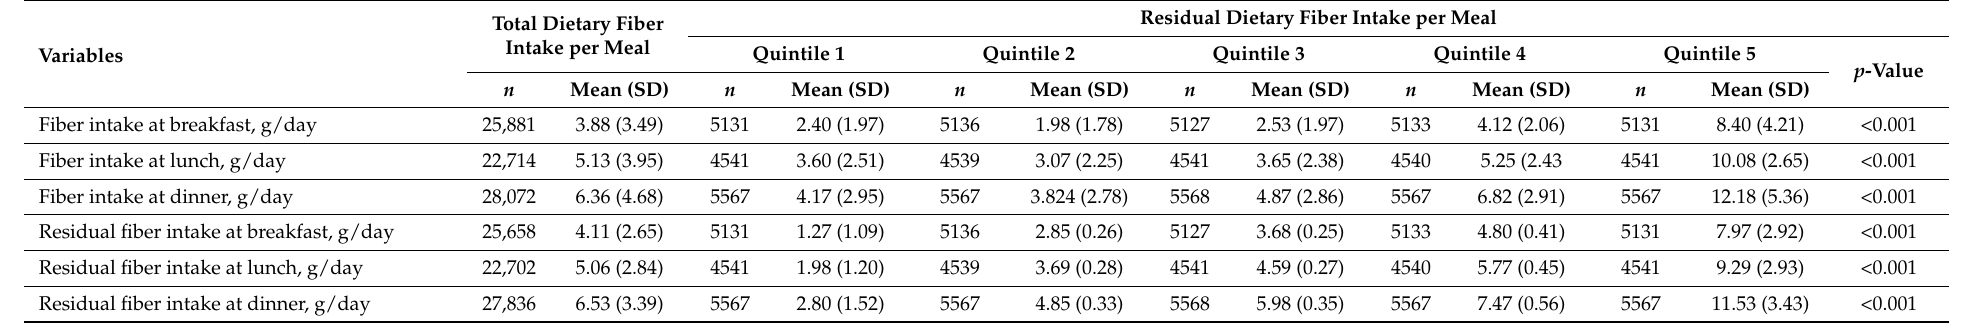
Table 2. Baseline characteristics of participants according to quintiles of dietary fiber intake per meal by using the residual method among adults in the NHANES,